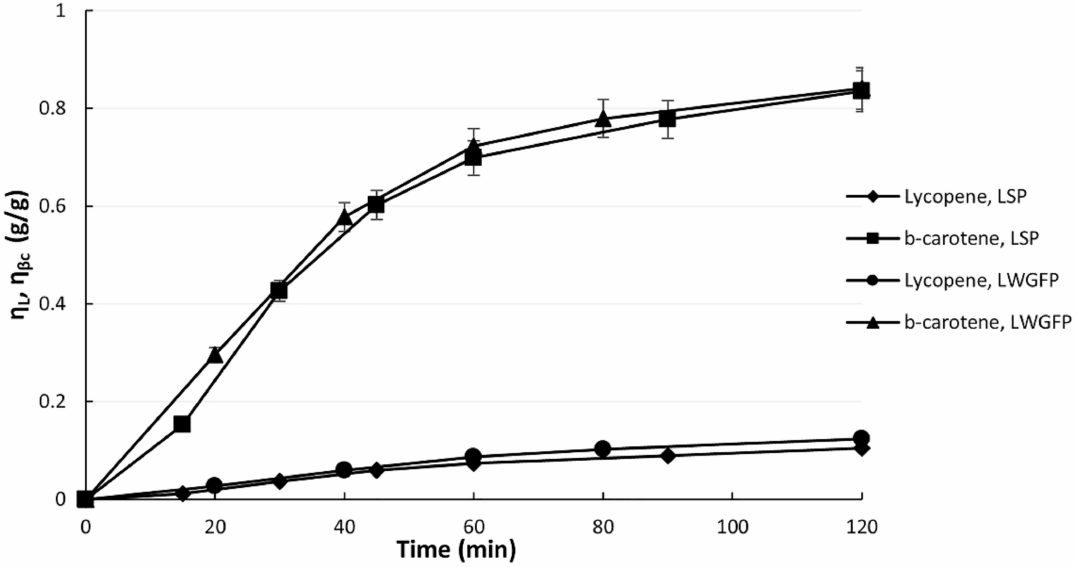
Figure 3. Lycopene and β -carotene extraction yield ( η L and η β c ) vs. extraction time, evaluated during trials #6 and #7 performed with layered configurations (LSP and LWGFP, respectively). For each layered configuration, non-significant differences ( p > 0.05) between the experimental points were